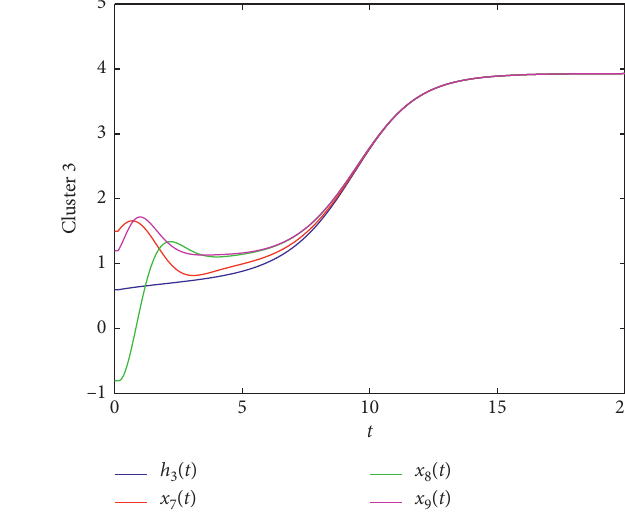
Figure 4: State trajectories in cluster 3.